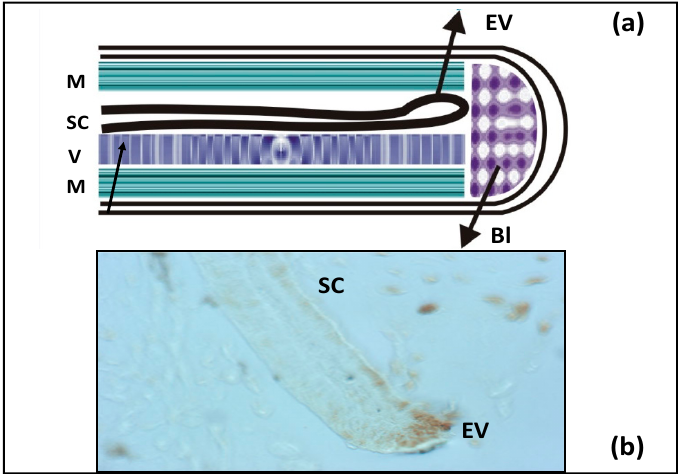
Figure 4. ( a ) Schematic diagram of tail regeneration in the newt. SC—spinal cord, EV—ependymal vesicle, V—vertebra, M—muscles, Bl—blastema. ( b ) Histological picture of growing SC with EV on the edge. EV cells proliferate (brown color—BrdU-positive cells).